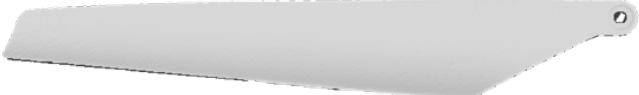
Figure 12. The obtained merged shape surface, created by matching the different sources.